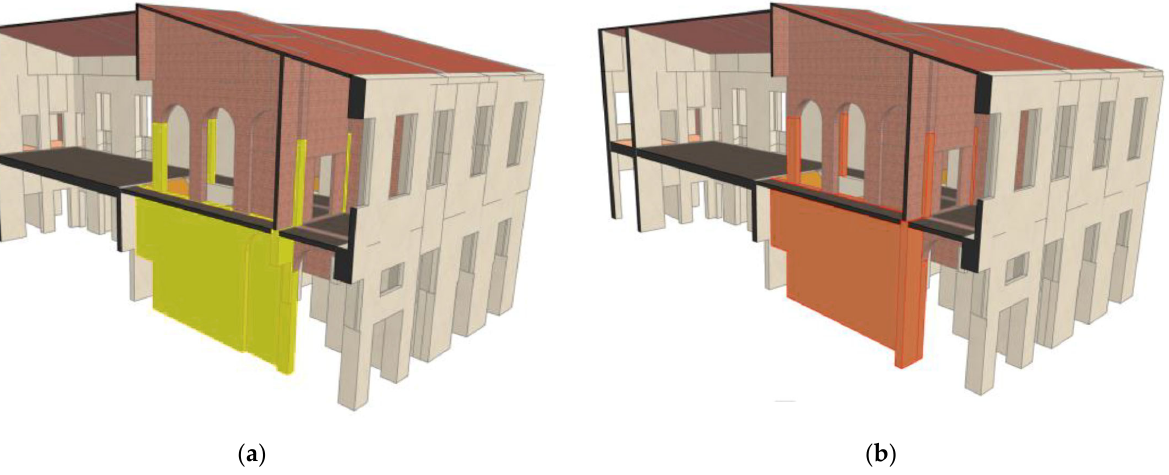
Figure 14. Strengthening interventions on the structural model of the “Bernardo Rucellai” school in Archicad: ( a ) current and ( b ) post ‐ intervention status. Archicad: ( a ) current and ( b ) post-intervention